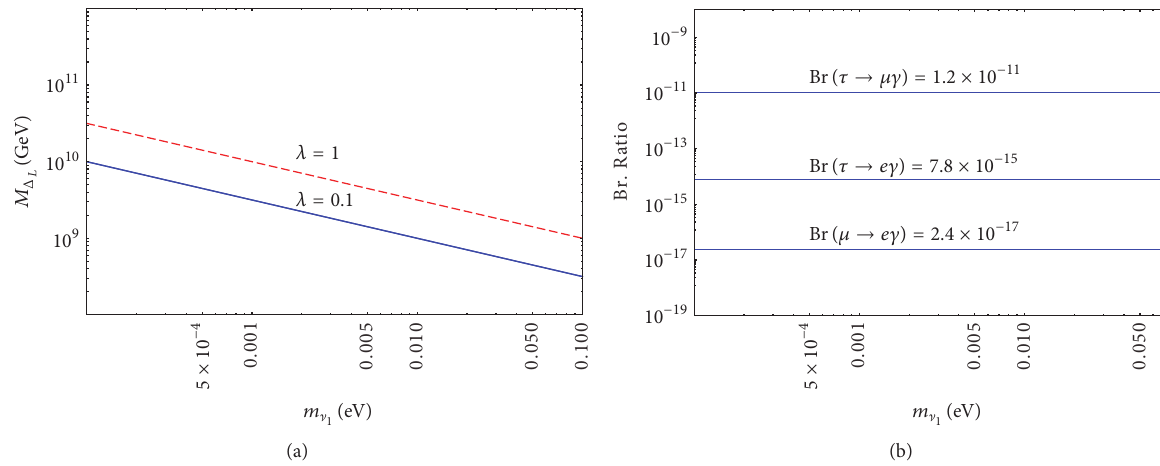
Figure 1: Variation of scalar triplet mass 𝑀 Δ (a) and LFV branching ratio (b) as a function of the lightest neutrino mass for different values of 𝐿 𝜆 in a type II seesaw dominant model where we have followed normal ordering. The three almost horizontal lines represent the LFV branching ratios for 𝑀 = 1.3 TeV.